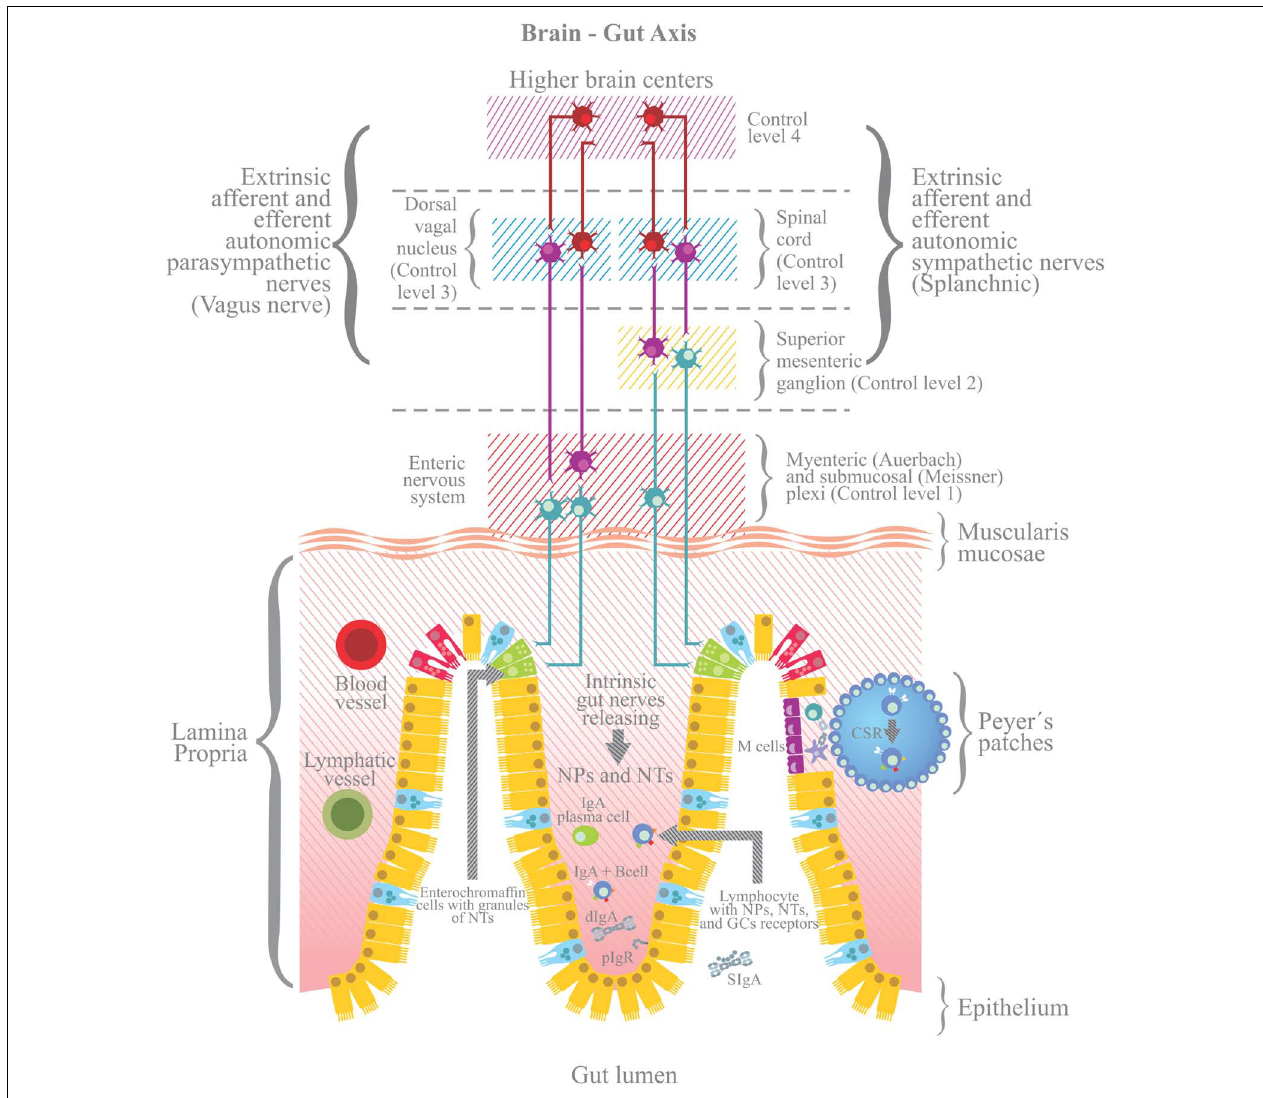
FIGURE 2 | Stress also triggers the activation of the enteric nervous system, including afferent and efferent intrinsic intestinal nerves (afferent nerves send signals from periphery to the brain; efferent nerves from the brain to the periphery) and extrinsic innervations, whether sympathetic (splanchnic) or parasympathetic (Vagus nerve). The enteric